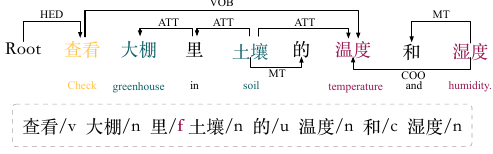
Figure 6. Example of dependency relationship and natural language command lexical annotation